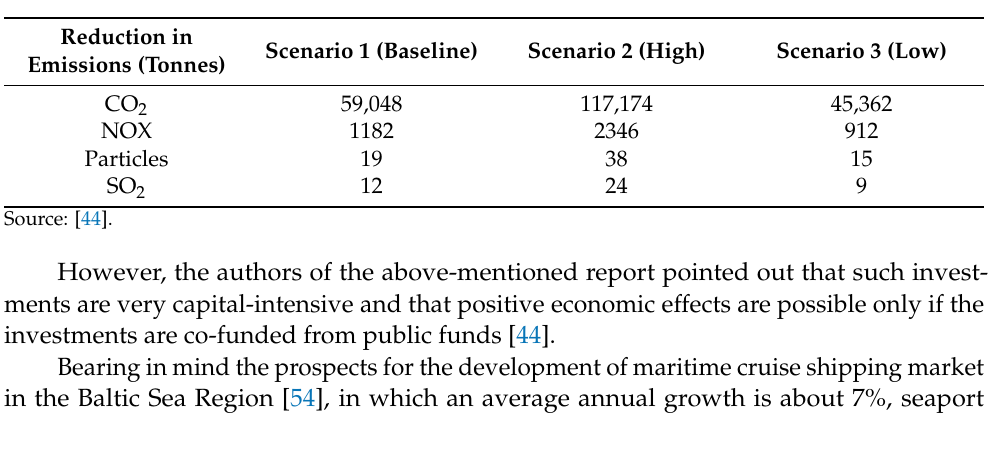
Table 3. Environmental effects of an Onshore Power Supply in the port of Copenhagen